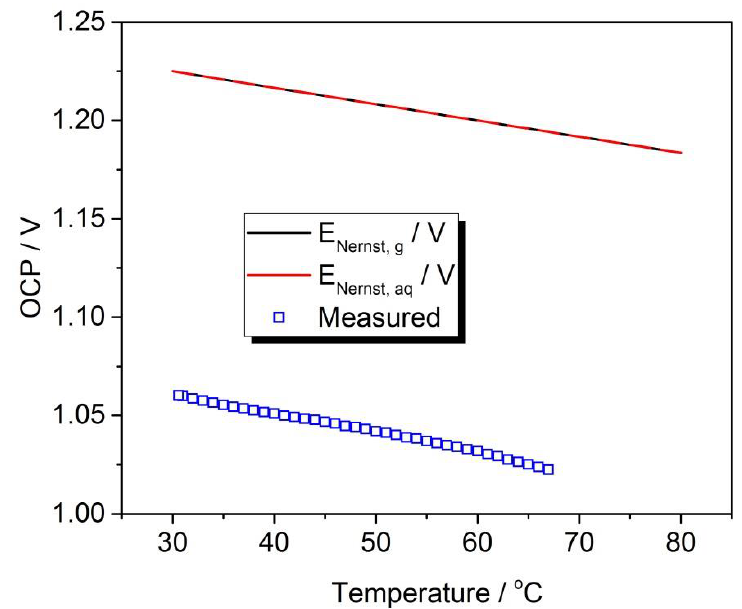
Figure 3. Calculated OCP dependence on temperature based on the Nernst equation using both the gaseous (Equation (5)) and aqueous (Equation (16)) models in addition to the experimentally measured OCPs for a Pt/C (JM) GDE.